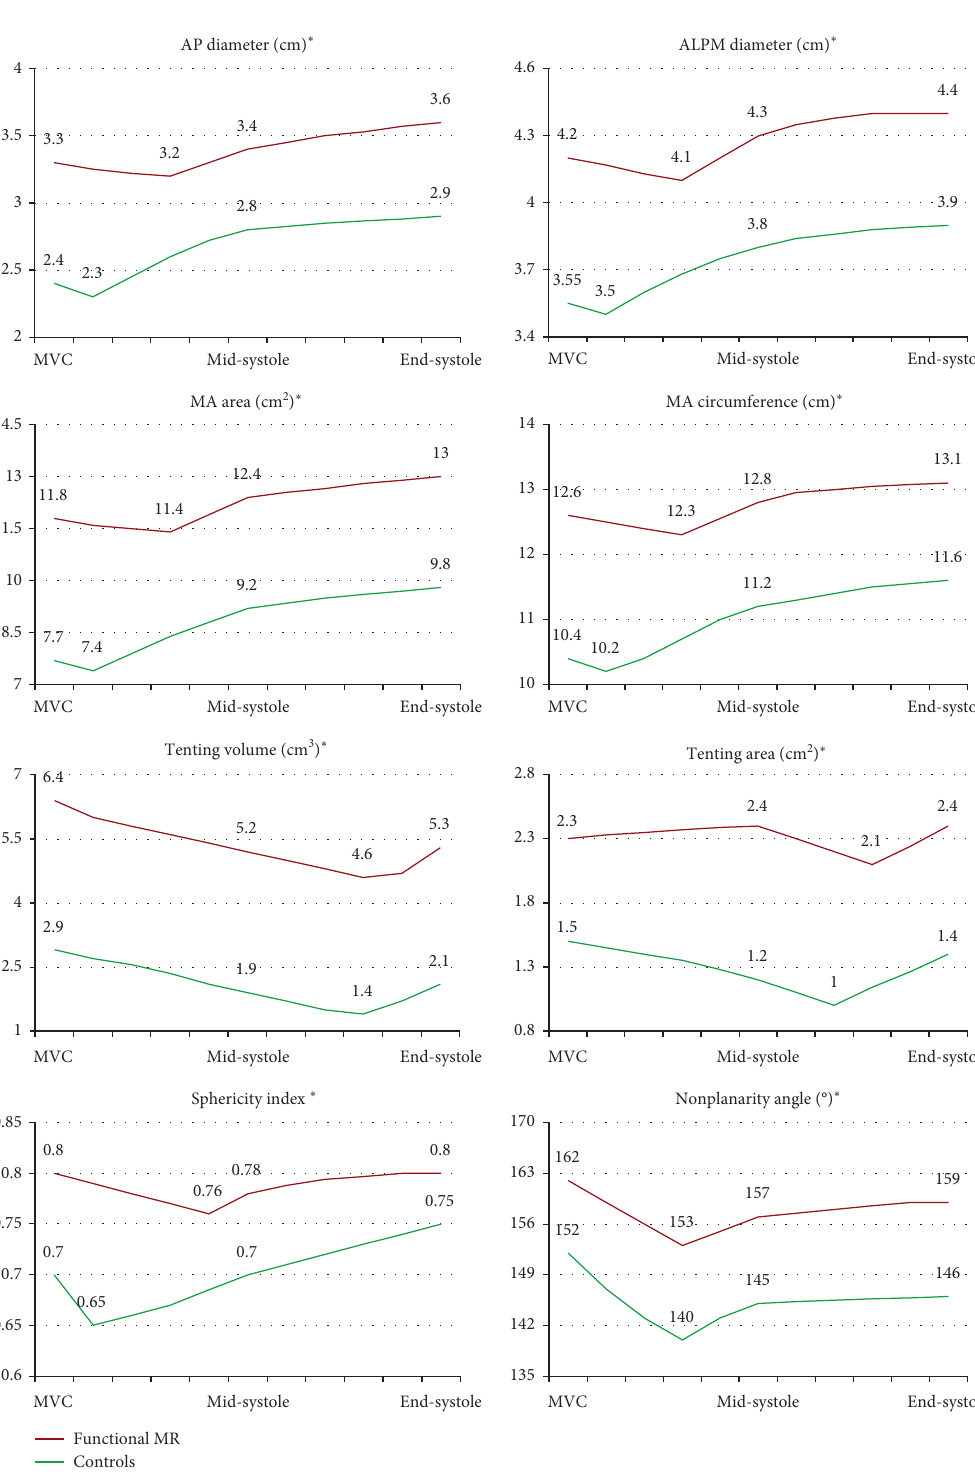
Figure 4: Dynamic changes of the mitral annulus geometry parameters during the cardiac systole in patients with functional mitral regurgitation (in red) and in control subjects (in green). AP: anteroposterior; ALPM: anterolateral-posteromedial; MA: mitral annulus; MVC: mitral valve closure. ∗ Statistically significant at every analyzed reference frame, p < 0 .